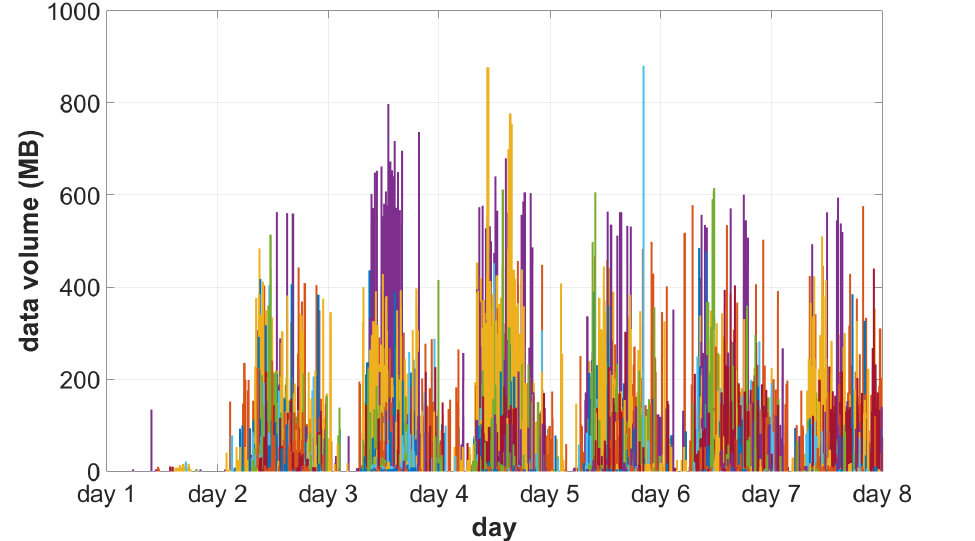
Figure 6. Traffic visualization during test days. Each series is marked with a separate bar. Different colors indicate acquisition devices.